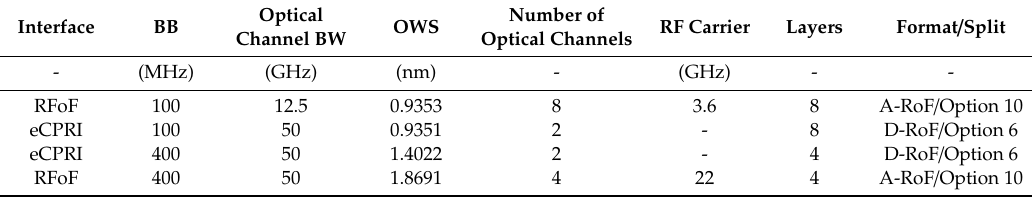
Table 6. Calculated comparative parameters for detailed scenario No. 4 to switch from D-RoF to A-RoF format (the optical channel count-down is starting from wavelength equal to 1675 nm)—Figures 10 and 12 (32-element antenna-array and 4-sector